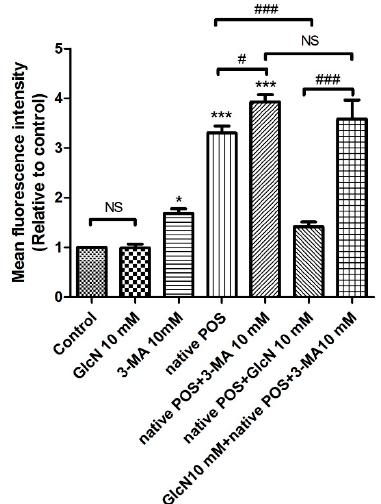
Figure 6. 3-Methyladenine (3-MA) attenuated the effect of glucosamine (GlcN) on native photoreceptor outer segment (POS)-derived lipofuscin-like autofluorescence (LLAF) in ARPE-19 cells. Cells were treated with GlcN (10 mM), 3-MA (10 mM), native POS, native POS + 3-MA, native POS + GlcN, or GlcN + native POS + 3-MA, and were compared with untreated cells. The mean fluorescence intensity (MFI) was quantified by flow cytometry following seven days of incubation. The results are represented as the mean ± SEM. The differences of the MFI between groups were compared using ANOVA, and Tukey’s test was used for the post hoc analysis; ns, not significant; * p < 0.05 versus the control group; *** p < 0.001 versus the control group; # p < 0.05; ### p < 0.001.